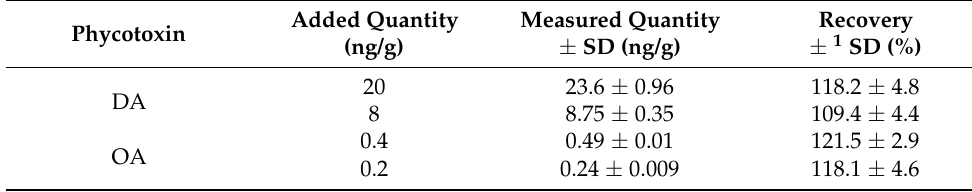
Table 1. Recoveries of DA and OA from seawater (n = 3). Added Phycotoxin